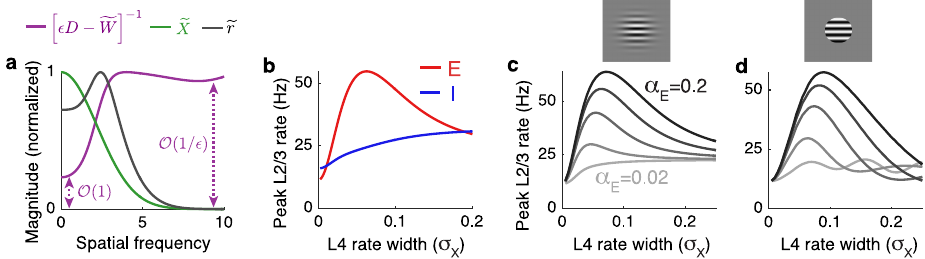
Fig 6. Spatial filtering of external input and the dependence of suppression on outgoing synaptic projection width. a) The magnitude of the spatial filter, ½ (cid:15) D (cid:0) f W ð n Þ(cid:138) (cid:0) 1 , imposed by recurrent connections (purple), the external input ( e X ð n Þ , green) and the resulting firing rate profile ( e r ð n Þ , black) as a function of the spatial frequency, ffiffiffiffiffiffiffiffiffiffiffiffiffiffiffiffi p , from the simulation in Fig 5j–5o. Magnitude is measured by the Frobenius norm for k n k¼ m 2 þ n 2 ½ (cid:15) D (cid:0) f W ð n Þ(cid:138) (cid:0) 1 . Curves normalized by their peaks. b) Firing rates of excitatory (red) and inhibitory (blue) neurons with receptive fields at the center of a grating stimulus plotted as the width of the stimulus increases (represented by increasing σ X ) using parameters from Fig 5j–5o. c) Same as b, but the excitatory rate is plotted for different widths of the excitatory synaptic projection width, α . d) Same as c, but firing rates in L4 are shaped like a disc with radius σ E instead of a Guassian with width parameter σ X